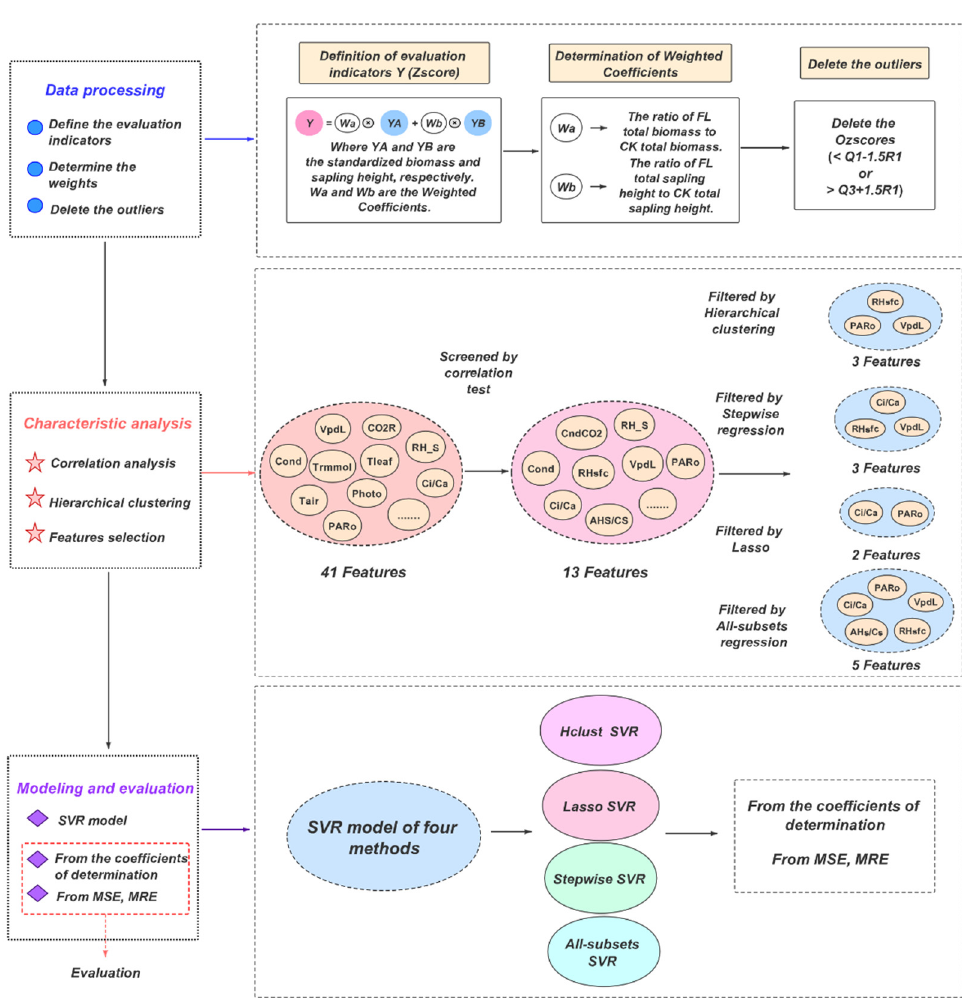
Figure 1. Flow chart of methodology.